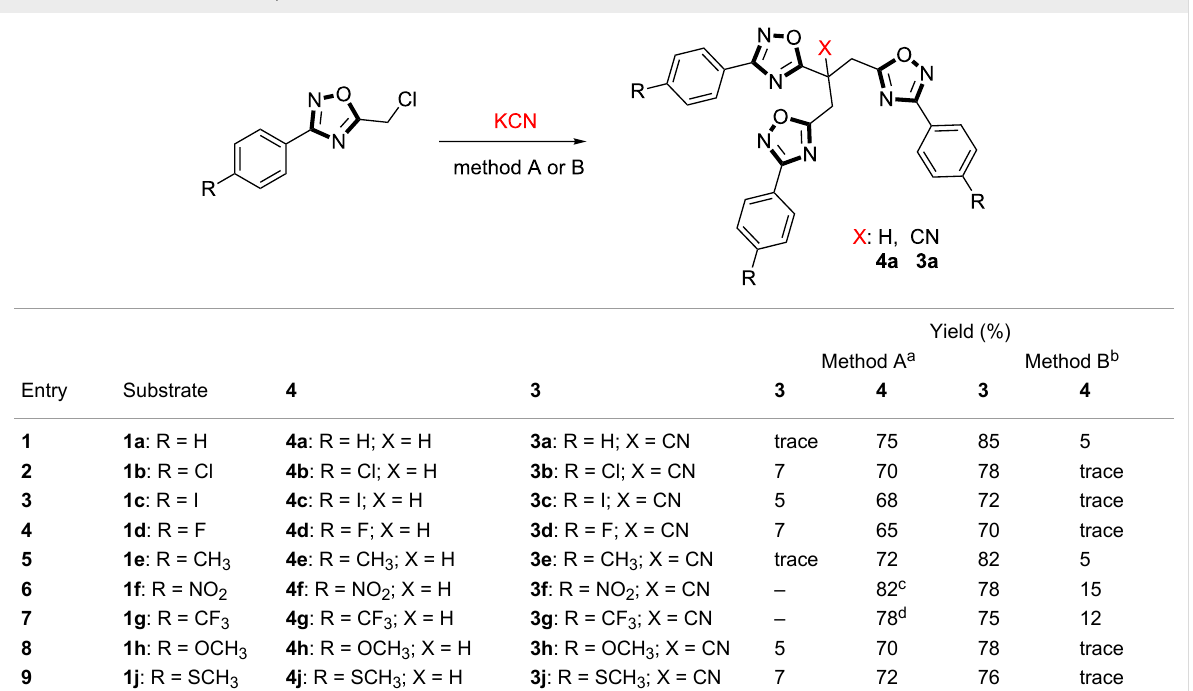
Table 2: Formation of 3 and their parent alkanes 4 .